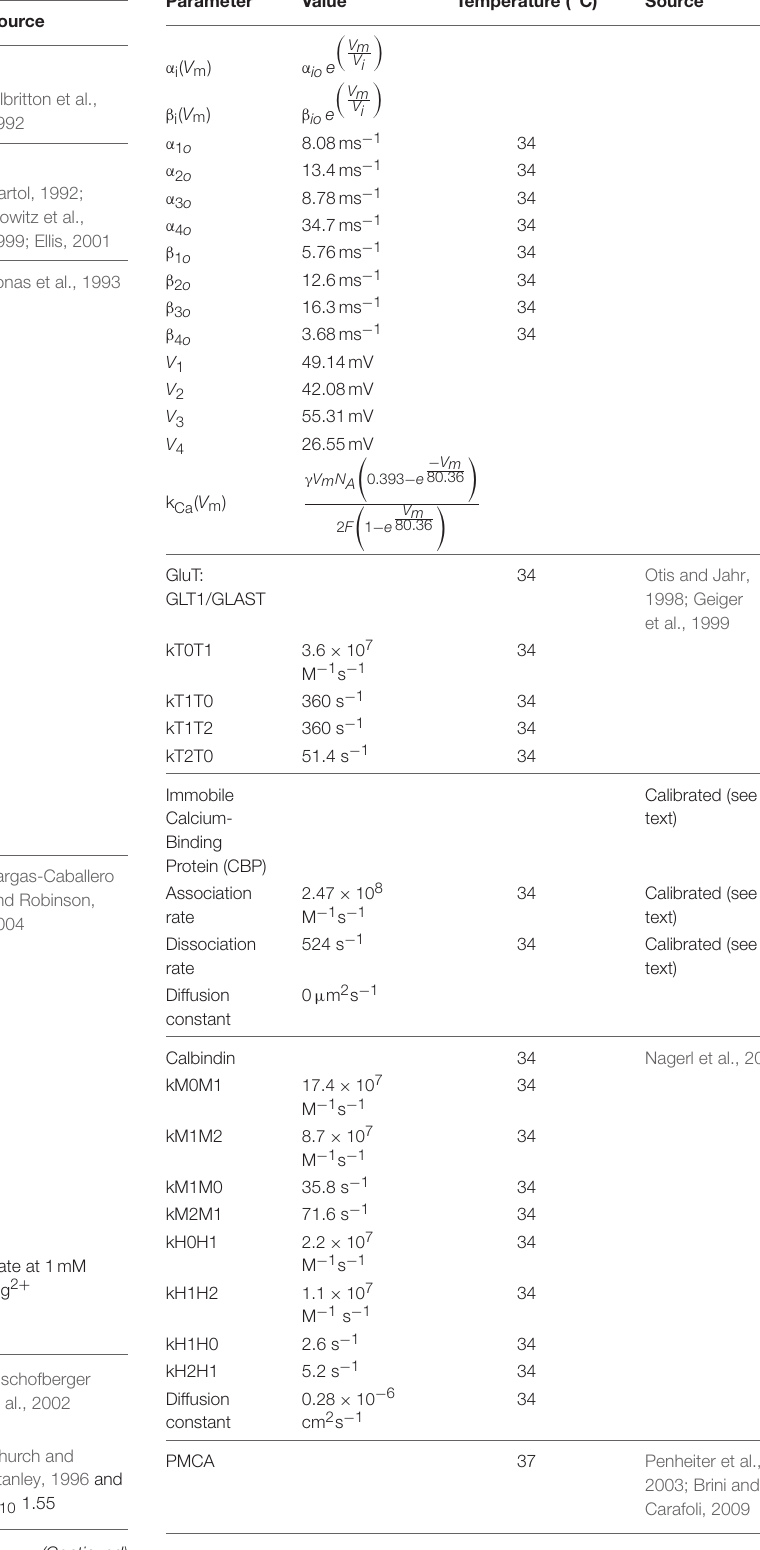
Parameter Value Temperature ( ◦ C) Allbritton et al., 1992